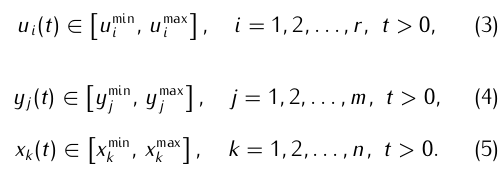
are finally implemented using fixed-point architectures.